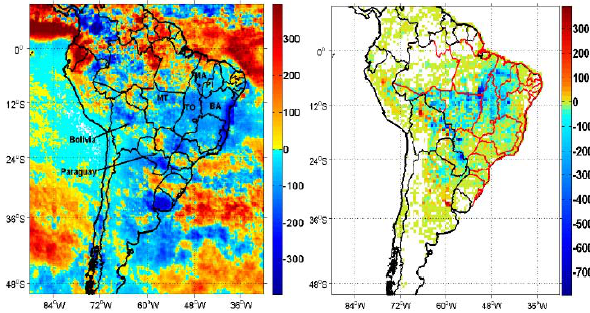
Fig. 7. Regional variability of the 6-month rainfall anomaly (left) and spatial distribution of the observed 2008 decrease in the number of September fires in relation to 2007 (right). See text for details.